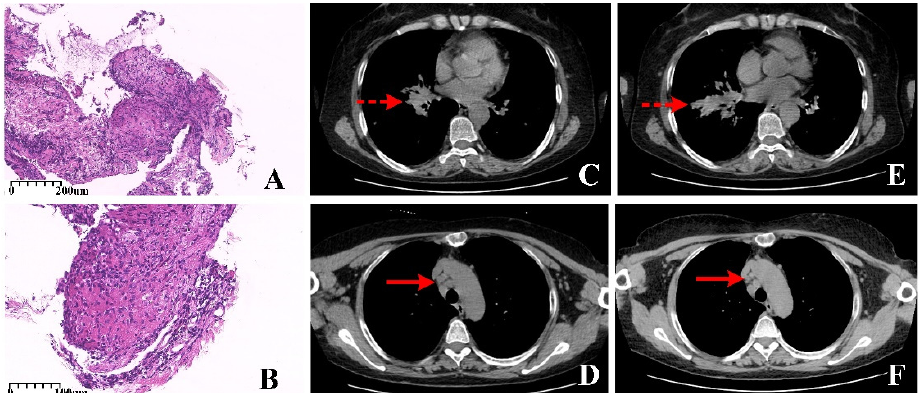
Figure 2. Histopathology ( A , HE × 100; B , HE × 200), axial view of the high-resolution (HR) CT ( C , D , pre-antituberculosis; E , F , post-antituberculosis). The bronchoscope detected obvious local occupying at the opening of basal segment bronchus of the lower lobe; the lesion was so protruding that the bronchoscope was unable to move forward. Therefore, the samples were taken at the lesion occupying of bronchial orifice. Histological analysis of a specimen showed non-caseating epithelioid granulomas nodules were composed of tightly clustered epithelioid histiocytes and revealed chronic inflammation associated with exuberant granulation tissue, obviously accompanying a large number of multinucleated giant cells and acellular hyaline substances between the nodules (Figure 2A, HE × 100). Additionally, other specimens showed chronic inflammation associated with exuberant granulation tissue and numerous epithelioid cells (Figure 2B, HE × 200). After that, standard anti-tuberculosis treatment was carried out. After six months, significant progression was revealed in the hilar mass (dotted arrows) and the enlarged lymph nodes (dash arrows) on HR CT (Figure 2C,D pre-anti tuberculosis; Figure 2E,F post-anti tuberculosis). Repeated flexible bronchoscope biopsy demonstrated pathological findings consistent with the prior specimens. Therefore, treatment with 0.5 mg/kg prednisolone was started, and all physical findings remained stable due to the corticosteroid treatment alone. A careful review of the clinical history and exclusion of other causes of pulmonary lesions helped make the final diagnosis of sarcoidosis. Sarcoidosis is a systemic disease characterized by a non-caseous necrotizing granuloma, affecting every organ system in the body [3]. A total of 90% of sarcoidosis patients have varying degrees of chest invasion with non-typical presentation in conventional imaging [4]. Additionally, the differential diagnosis mainly includes infections, especially tuberculosis, and malignancies, especially lung cancer and lymphoma. External